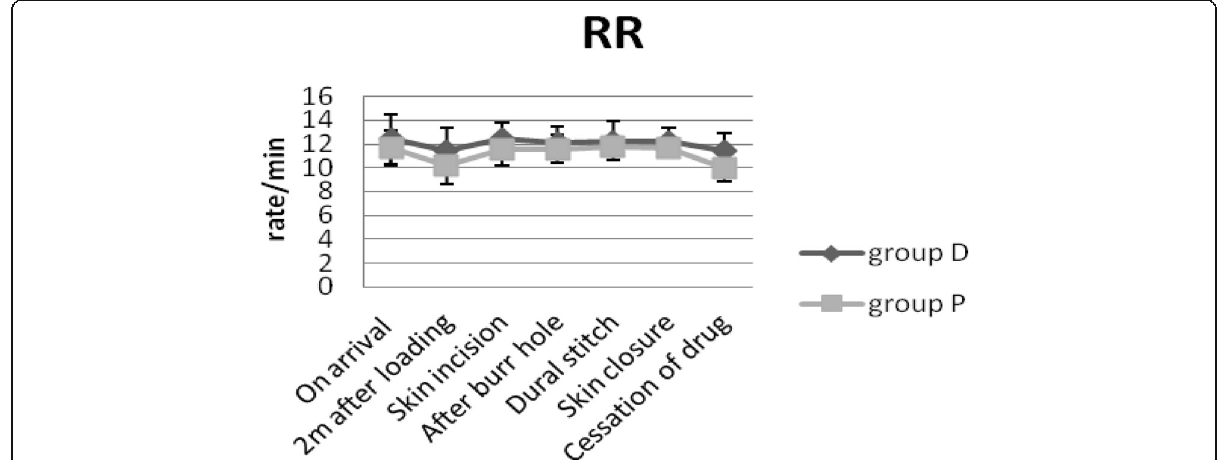
Fig. 4 Changes in RR. Changes in mean values of RR over time. Lines are mean RR and error bars are SD. *Statistical significance between